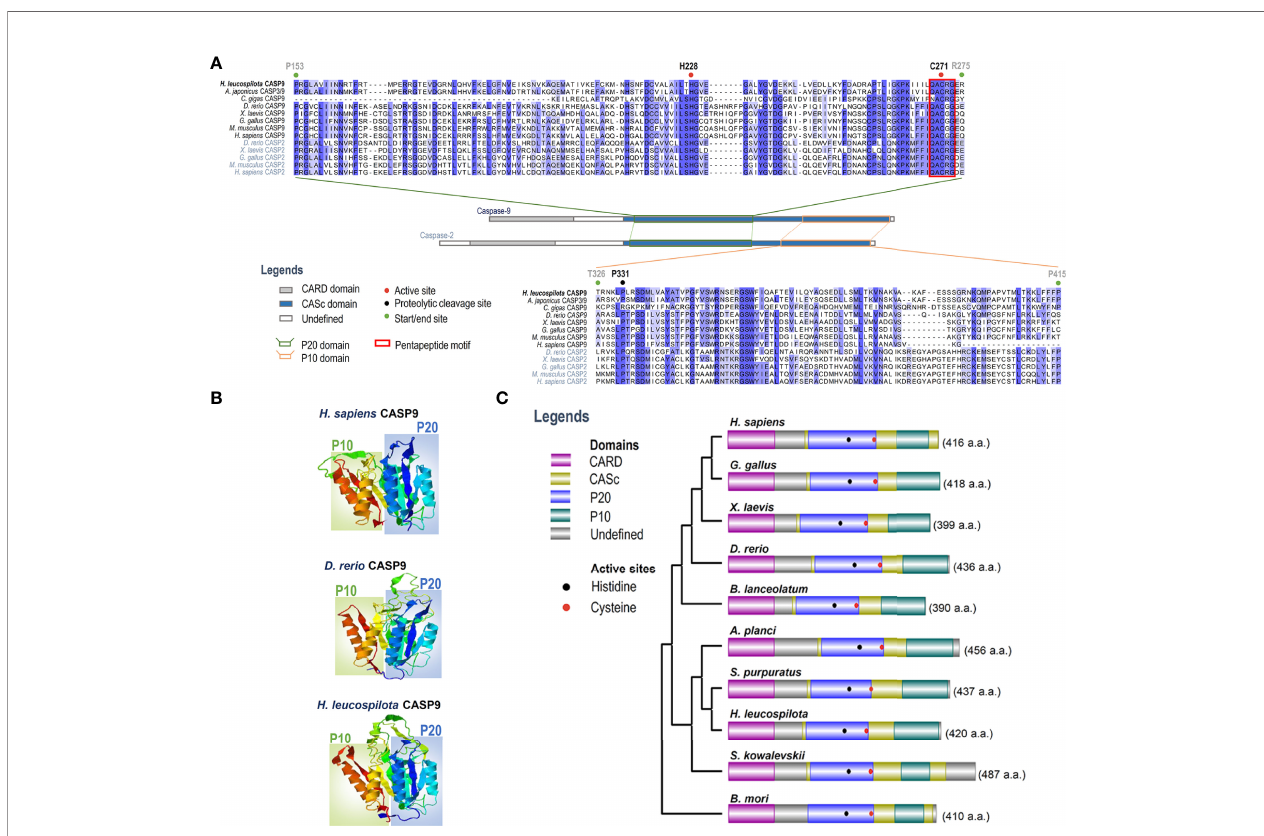
FIGURE 2 | Analysis on amino acid sequence alignment, and organization of domains and 3-D structures of caspase-9. (A) Amino acid sequence alignment of caspase-2 and caspase-9 in various species. Conserved amino acid residues are boxed in dark blue, and similarities in amino acid residues are highlighted in light blue. (B) Comparison on 3-D structures of CASc domains in caspase-9 among three species. Positions of the P20 and P10 subunits are boxed. (C) Protein structural organization of caspase-9 among various